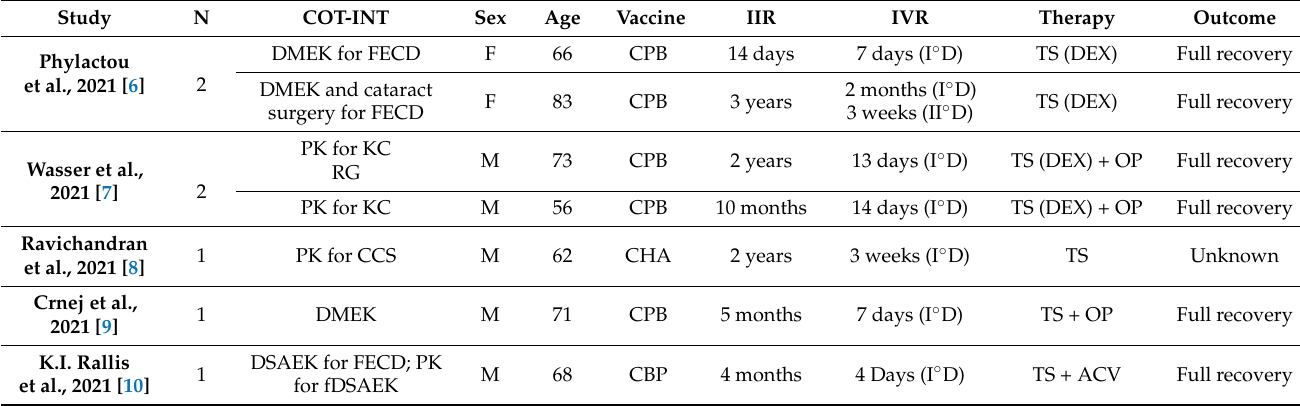
Table 1. Cases of corneal graft rejection after COVID-19 vaccination. COT-INT Cause of transplantation- Intervention; IIR: Interval intervention-rejection; IVR: Interval vaccine- rejection; F: female; M: male; CPB: Comirnaty, BNT162b2, BioNTech/Pfizer; DMEK: Descemet Membrane Endothelial Keratoplasty; FECD: Fuchs Endothelial Corneal Dystrophy; I ◦ D: first dose; II ◦ D: second dose; TS: topical steroid; DEX: Dexamethasone; PK: penetrating keratoplasty; KC: keratoconus;